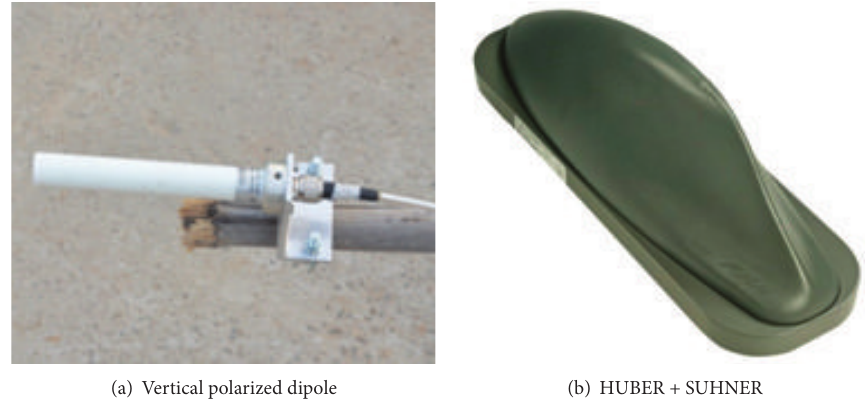
Figure 2: The features of antennas used at (a) TX and (b)